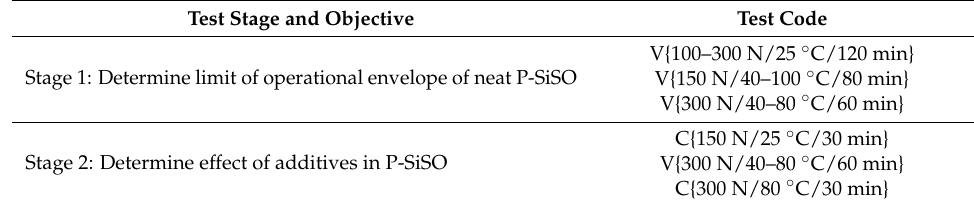
Table 1. Test codes describing conditions (load, temperature, duration) corresponding to the different tribotest